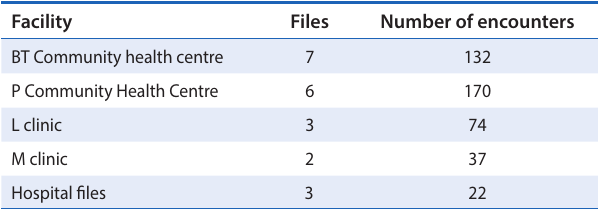
Table 2: Facility prescribing encounters indicating strength of sample Facility